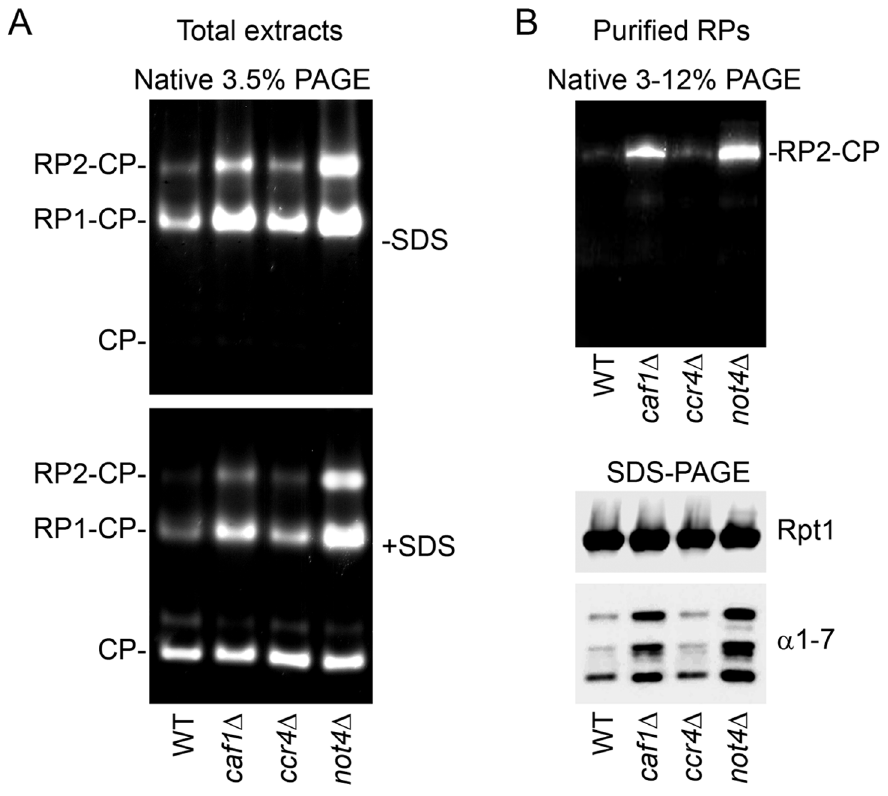
Figure 3. Proteasome was defective in not4 D cells but not in ccr4 D cells. A. Total cellular extracts were prepared from wild-type, caf1 D , ccr4 D , and not4 D cells and loaded on 3.5% native gels. After electrophoresis gels were incubated with Suc-LLVY-AMC to analyze the proteasome activity in the absence (-SDS) and then in the presence ( + SDS) of 0.02% SDS to detect the latent CP activity. The positions of double (RP 2 -CP) and single (RP 1 -CP) capped proteasomes and CP alone are indicated on the left. B. RPs were purified from wild-type, caf1 D , ccr4 D , and not4 D cells, loaded on a gradient 3–12% native gel and then analyzed for activity (upper panel). The same purified material was analyzed by SDS-PAGE and western blot with antibodies against the RP subunit (Rpt1) and with antibodies against CP subunits ( a 1-7) (lower panel).